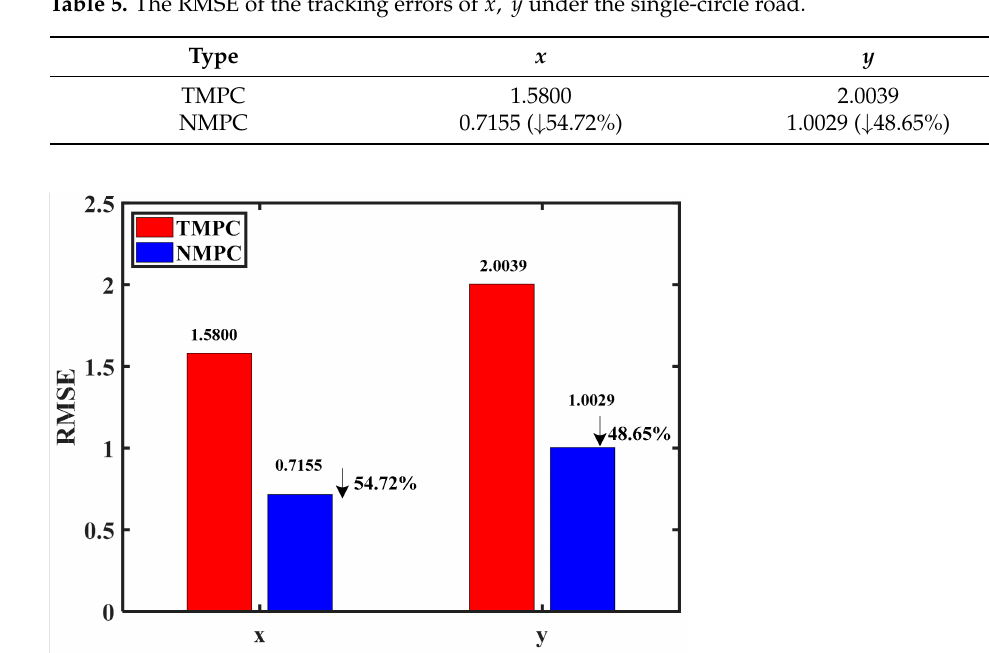
Table 5. The RMSE of the tracking errors of x , y under the single-circle road.